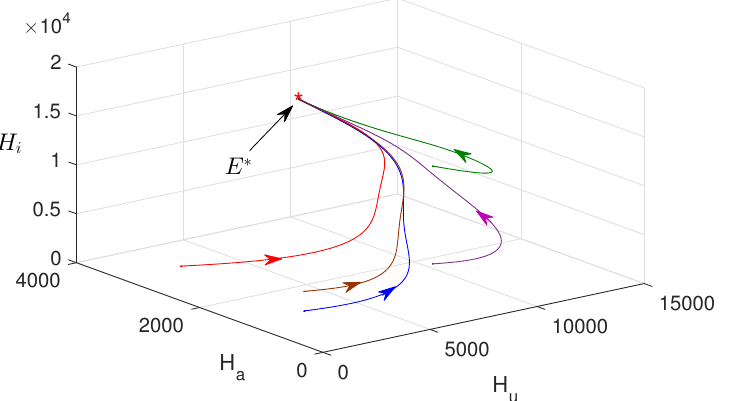
Figure 4. Phase portrait is plotted in H u Figure